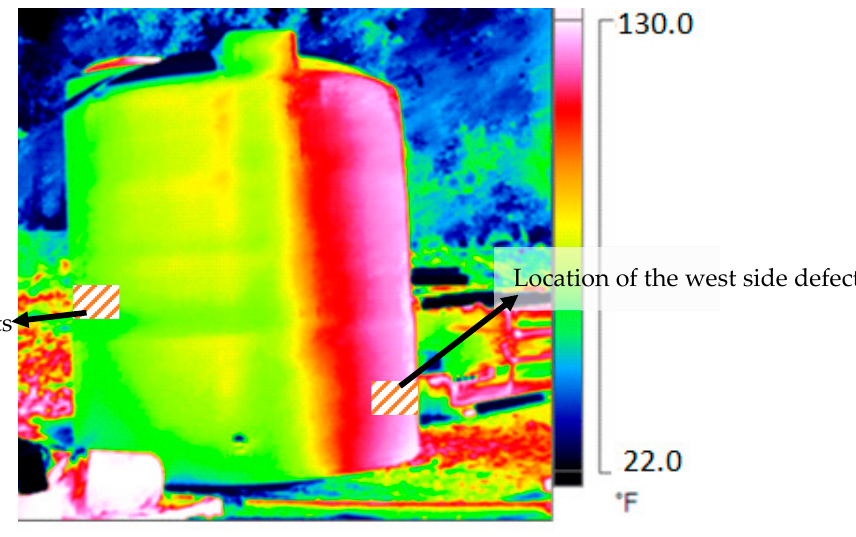
Figure 3. The non-uniform temperature on the tank (picture was taken in the afternoon when the sun was on the west side).